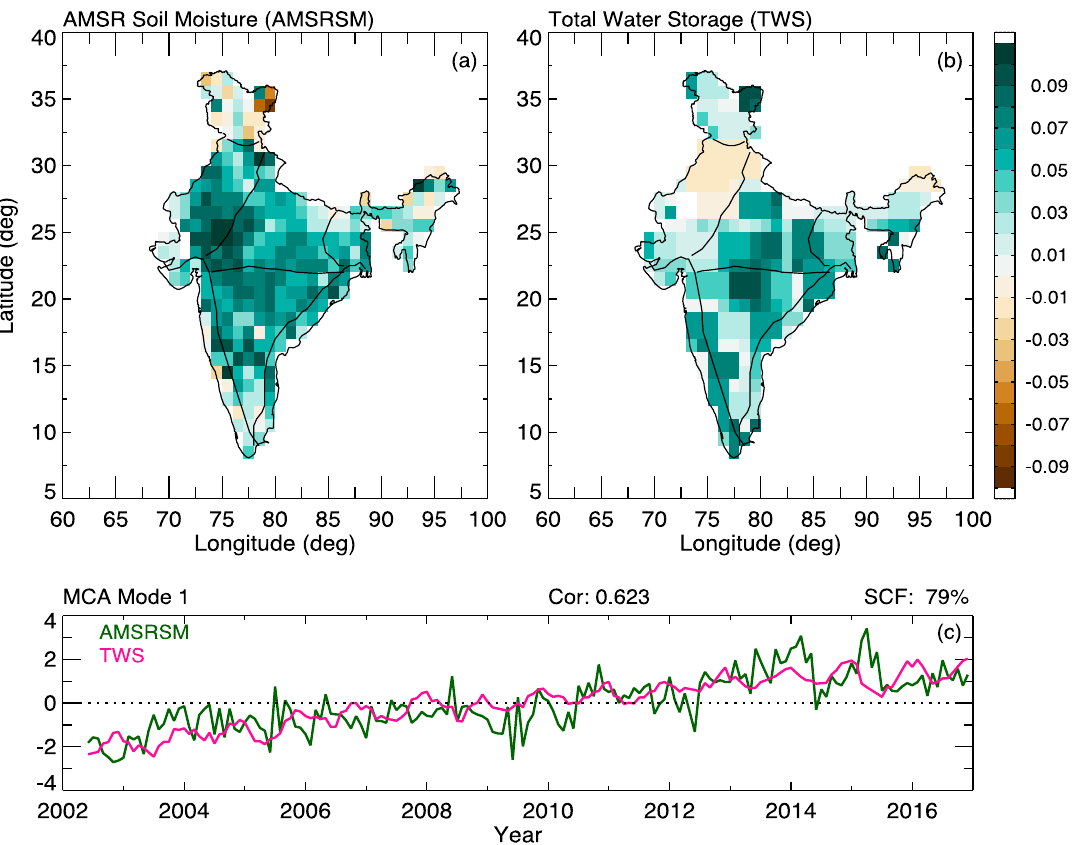
Figure 7. Spatial patterns of the first MCA mode associated with ( a ) AMSR soil moisture (AMSRSM) and ( b ) total water storage (TWS) during the period 2006–2016. ( c ) The corresponding covariance coefficients associated with AMSR soil moisture (green curve) and TWS (pink curve). The squared coefficient factor (SCF) and correlation coefficients are indicated on the top of the plot.